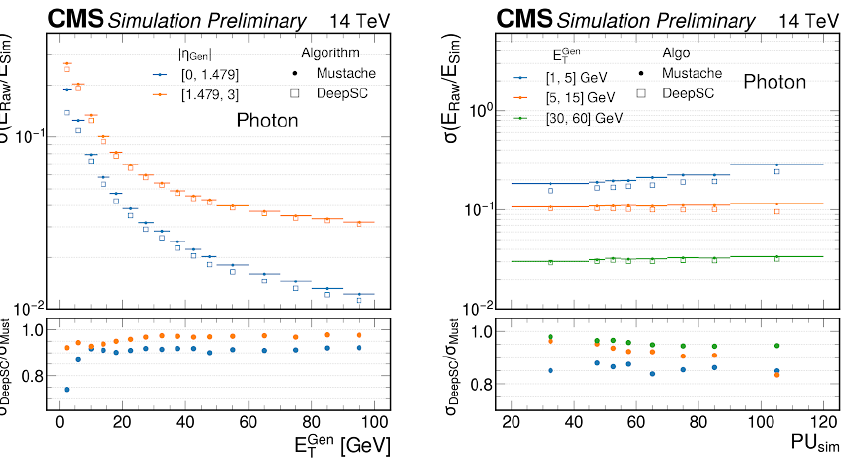
Figure 2. Energy resolution for DeepSC and Mustache algorithms. The resolution of the reconstructed uncorrected energy divided by the true energy deposits vs. generated transverse energy of the particle ( left ) and the number of simulated pileup interactions ( right ) is presented. The bottom panels show the ratio of the energy resolutions quantifying the improvement of the DeepSC model over the Mustache